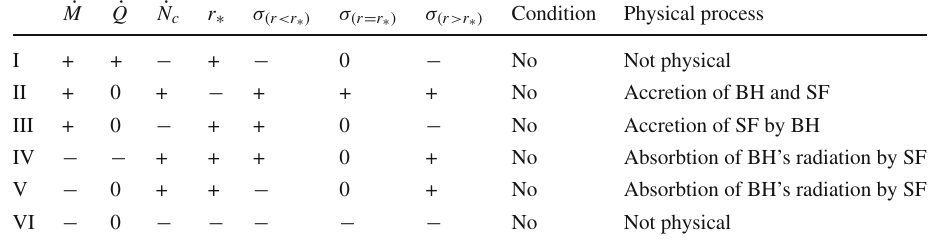
Bonnor–Vaidya BH and its cosmological SF parameters